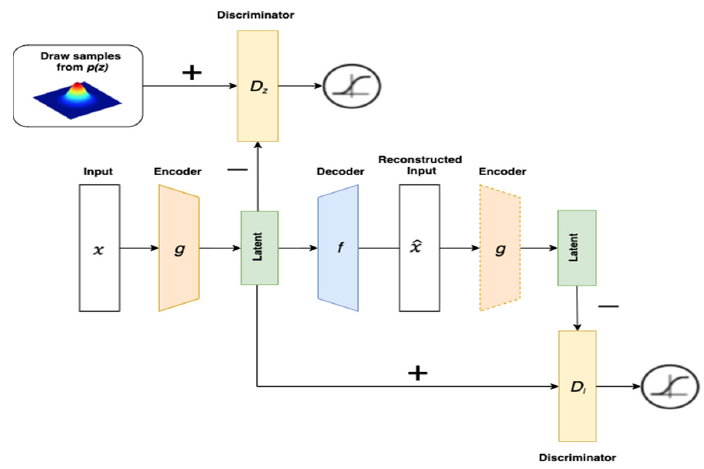
Figure 6. Architecture of the extended AAE, which is based on the AAE architecture, with the addition of discriminator D l . The dotted encoder is not updated during the